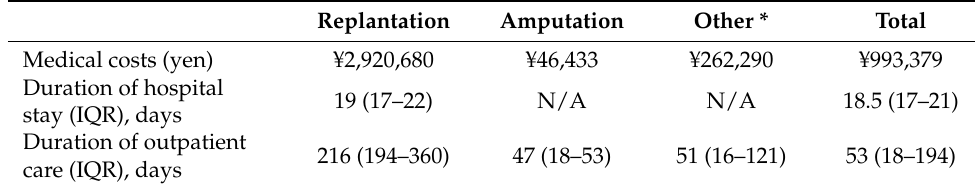
Table 2. The mean medical costs and median duration of